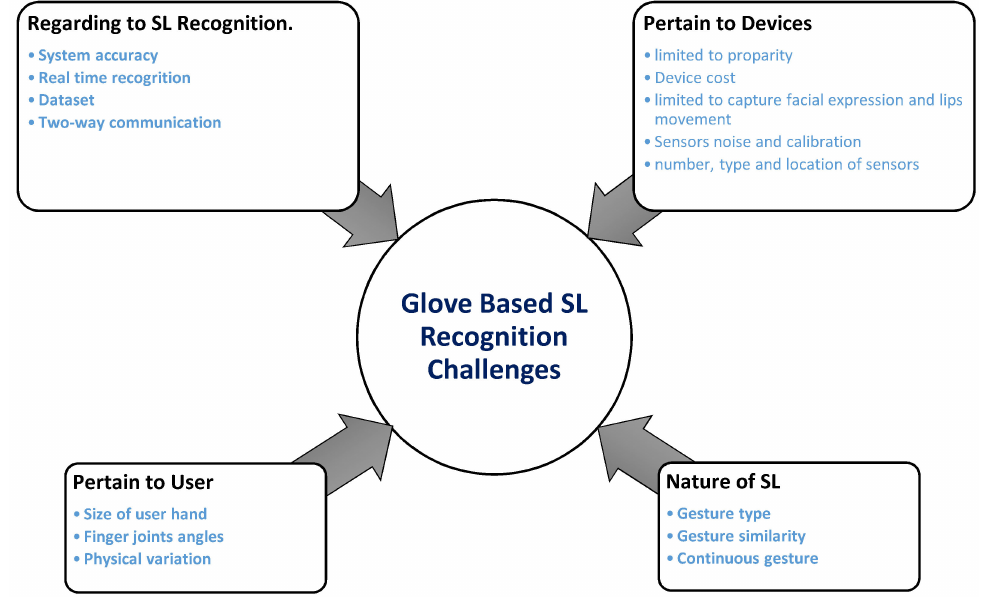
Figure 28. Categories of challenges for glove-based SL